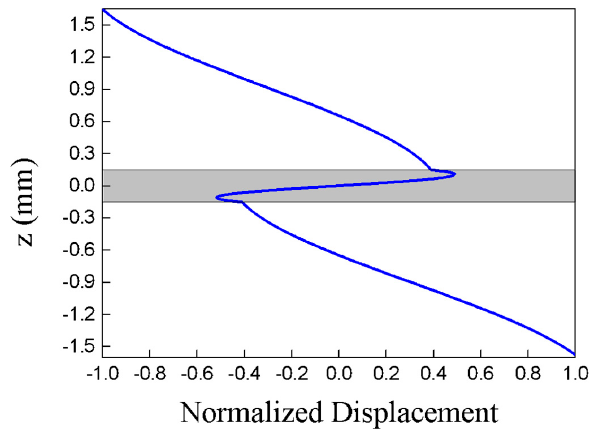
Figure 12. The displacement field of the second harmonic Lamb waves. Figure 12. The d isplacement field of the second harmonic Lamb waves.